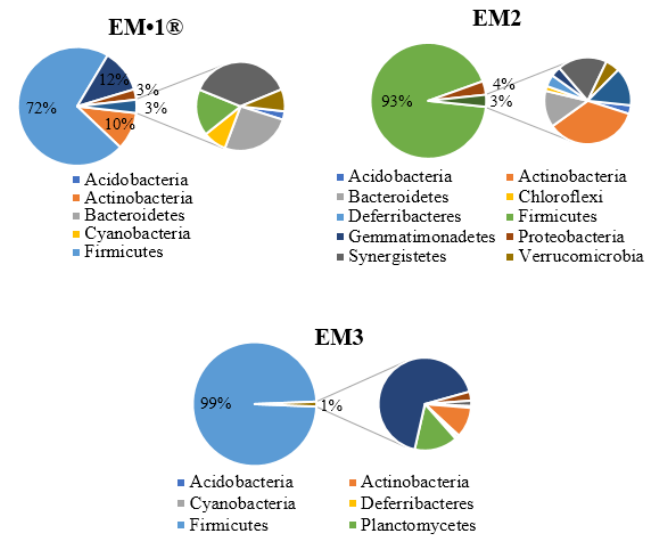
Figure 3. Distribution of OTUs of bacterial phyla in EM inoculants. EM•1®: commercial; EM2 = Produced in the region of Muriaé; EM3 = Produced in the region of